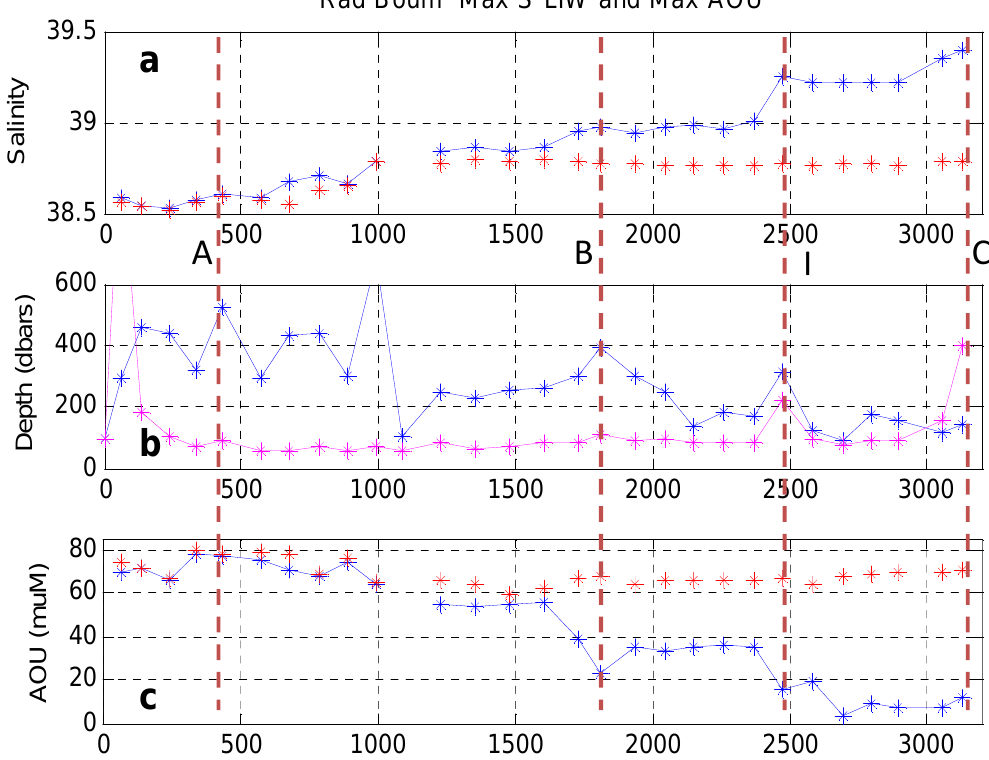
Fig. 3. Salinity (a) , depth ( b , dbars) and AOU ( c , µM) values found on each vertical profile along the BOUM section at the maximum of S (blue stars), and Salinity (a) and AOU (c) at the maximum of AOU (red stars). W-MLDs are indicated in mauve stars (b) . The dashed vertical lines (red) show the locations of eddies A, B, Ierapetra and C, from left to right respectively. The x-axis is graduated in km of transect from the SD station 27 near the mouth of the Rhˆone river. In the (a) and (c) panels, the stations where bottom depths were < 150dbars were kept